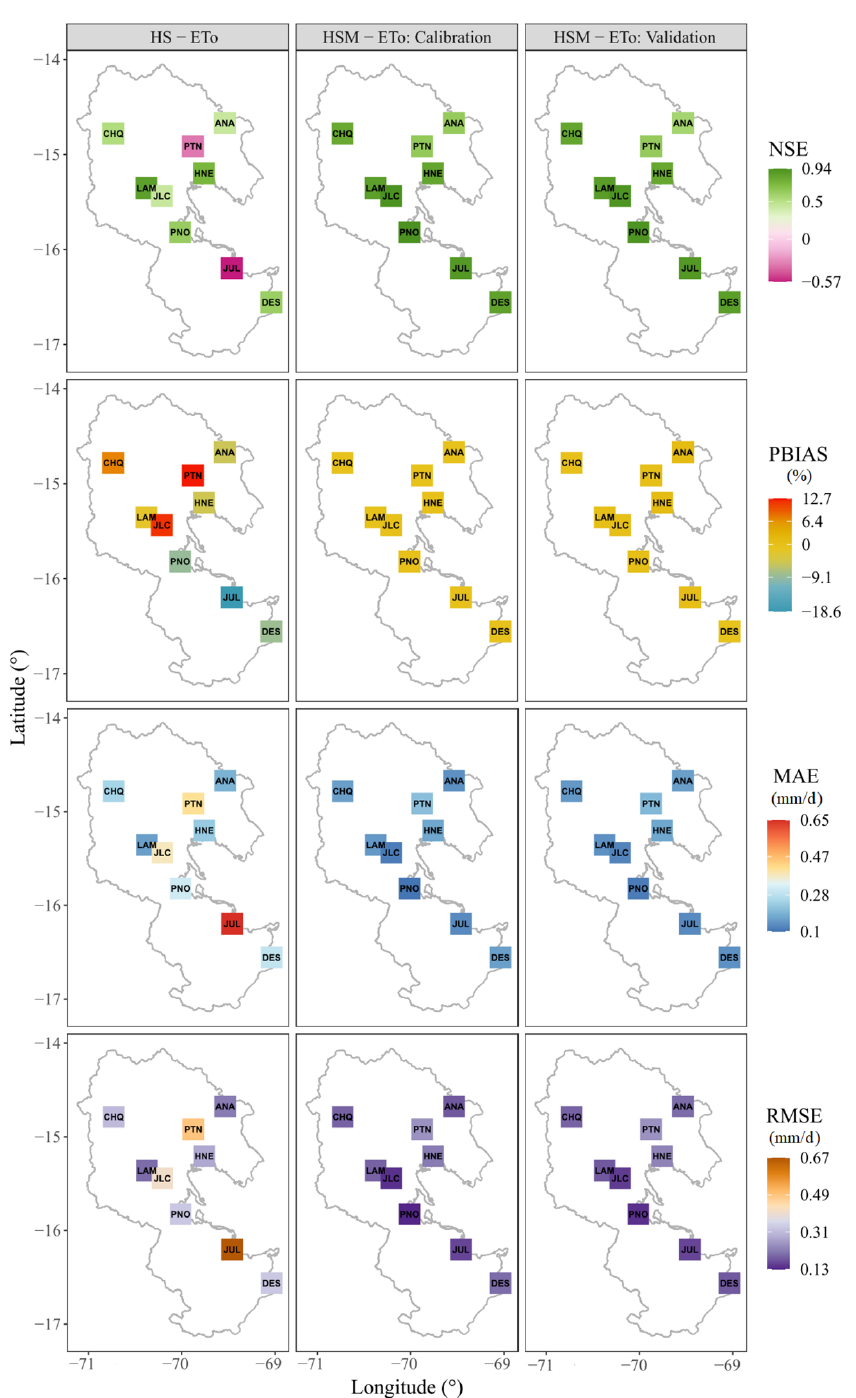
Figure 5. Spatial distribution of the NSE, PBIAS (%), MAE (mm/d) and RMSE (mm/d) from the ETo estimates of HS with original K RS , HSM with ˆ K RS in the calibration and validation phase. Study area in gray outline.